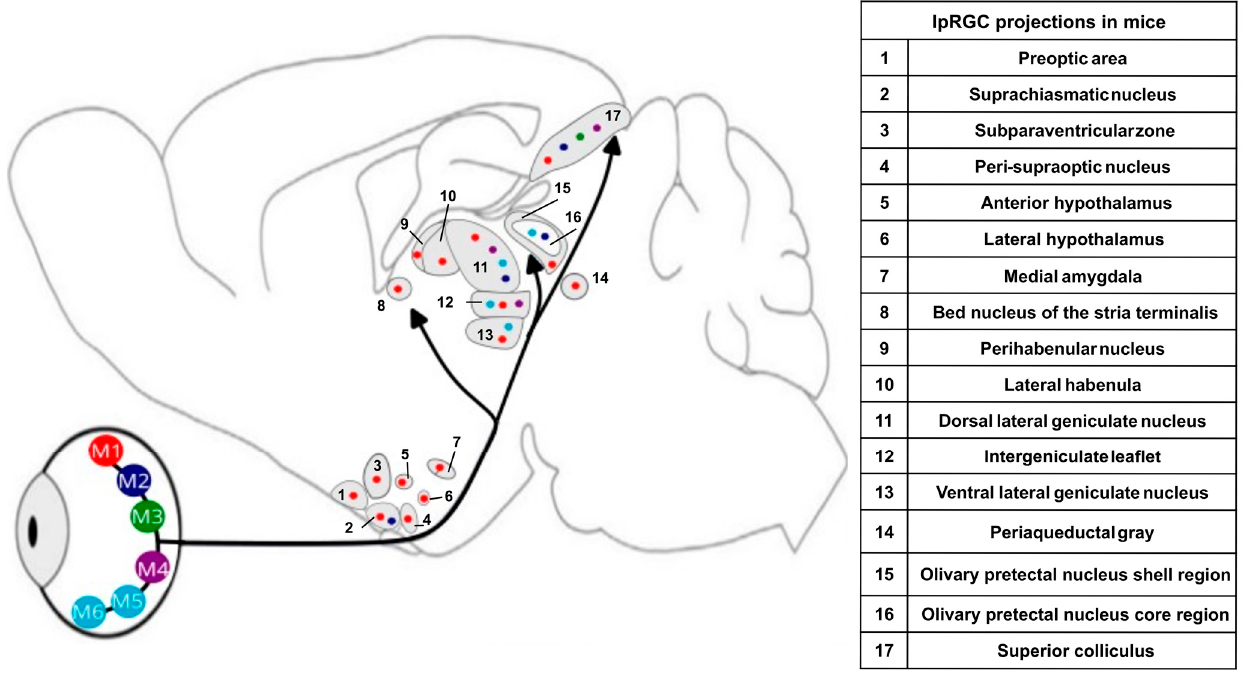
Figure 2. Schematic of main ipRGC projections in mice. Adapted with permission from [44,48]. Information from [36,44,46,48]. Numbers of the scheme correspond to numbers in the adjacent table. Coloured dots correspond to known projection of ipRGCs subtypes in rodents (M1 to M6).